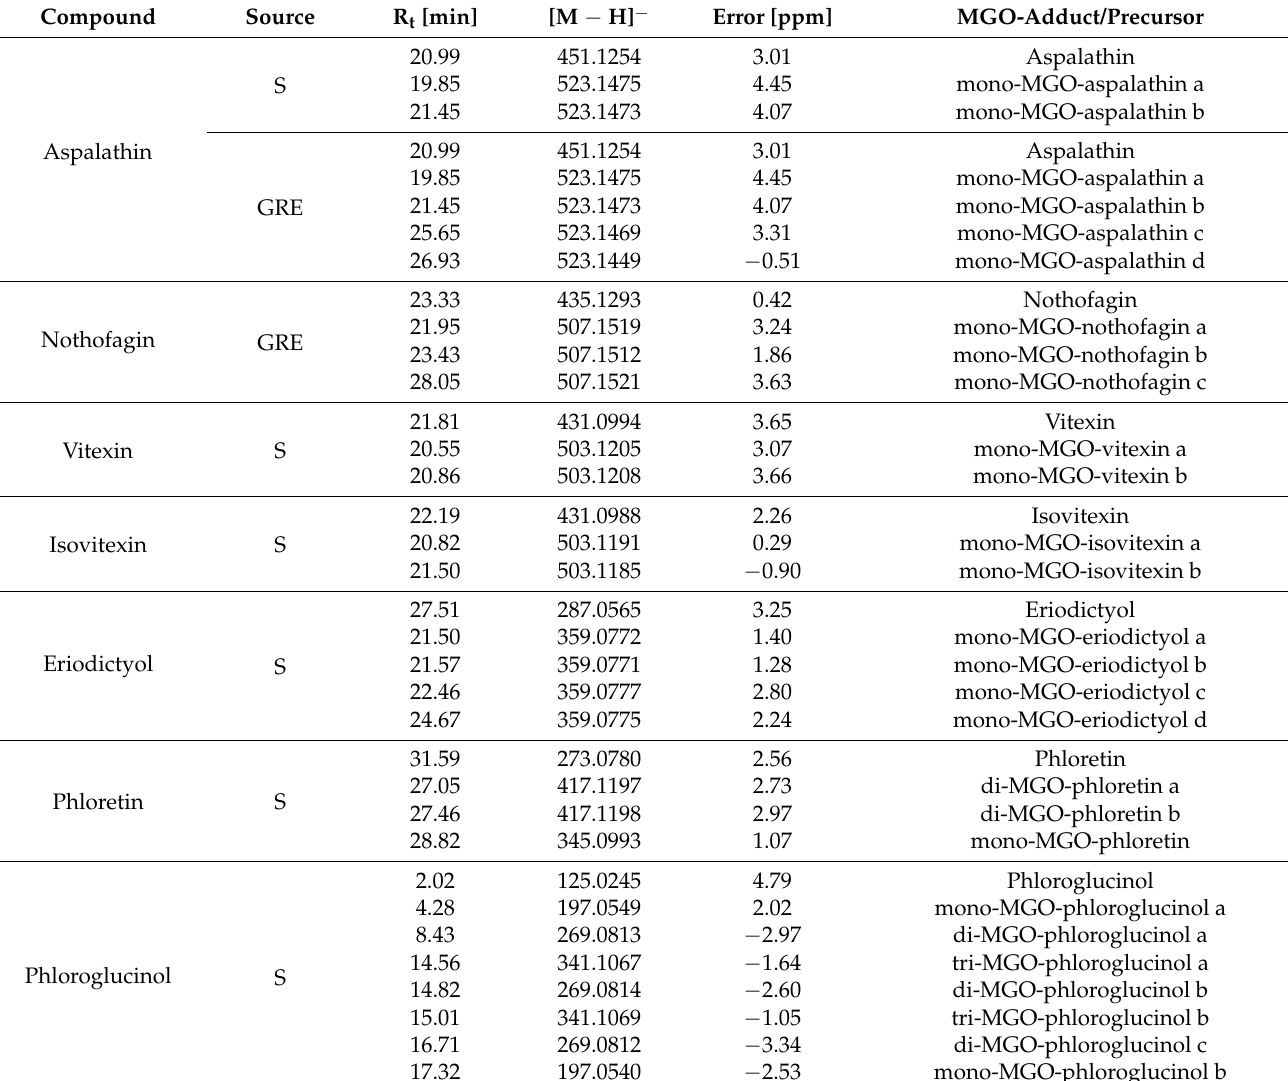
Table 3. Adducts of methylglyoxal and investigated compounds formed after 1 h of incubation in pH 7.4 phosphate buffer solution at 37 ◦